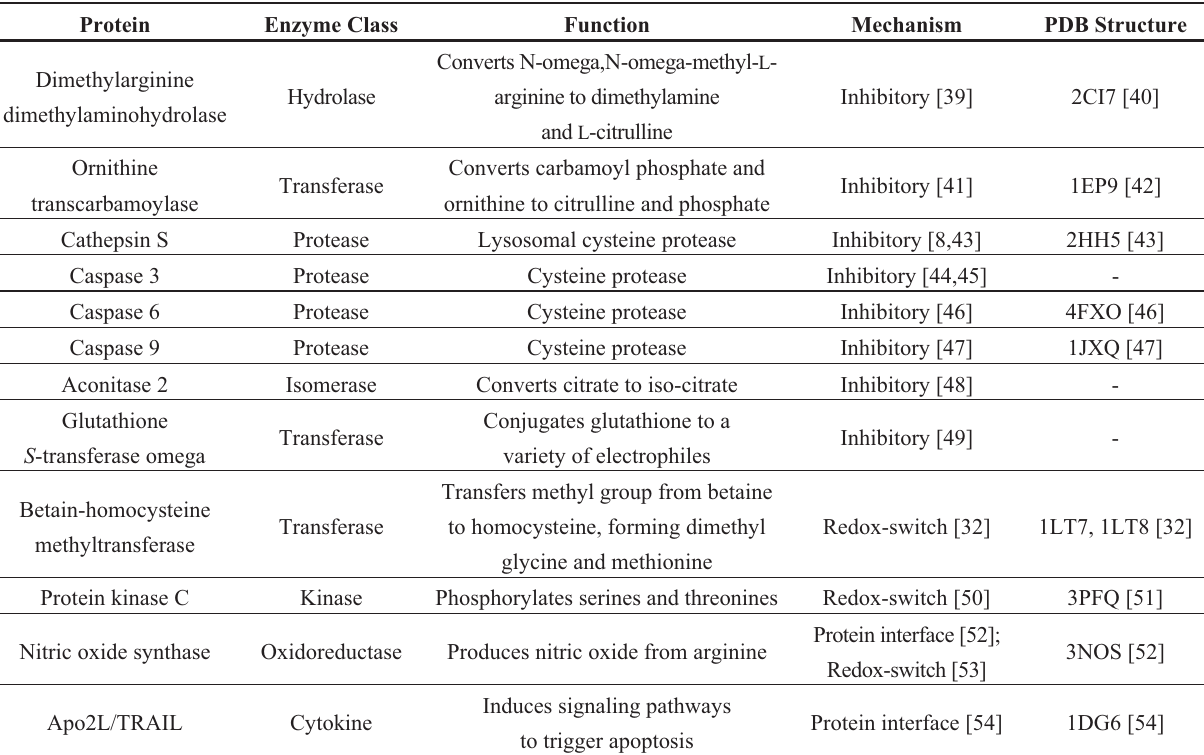
Table 2. Representative human proteins containing regulatory Zn 2+ -cysteine